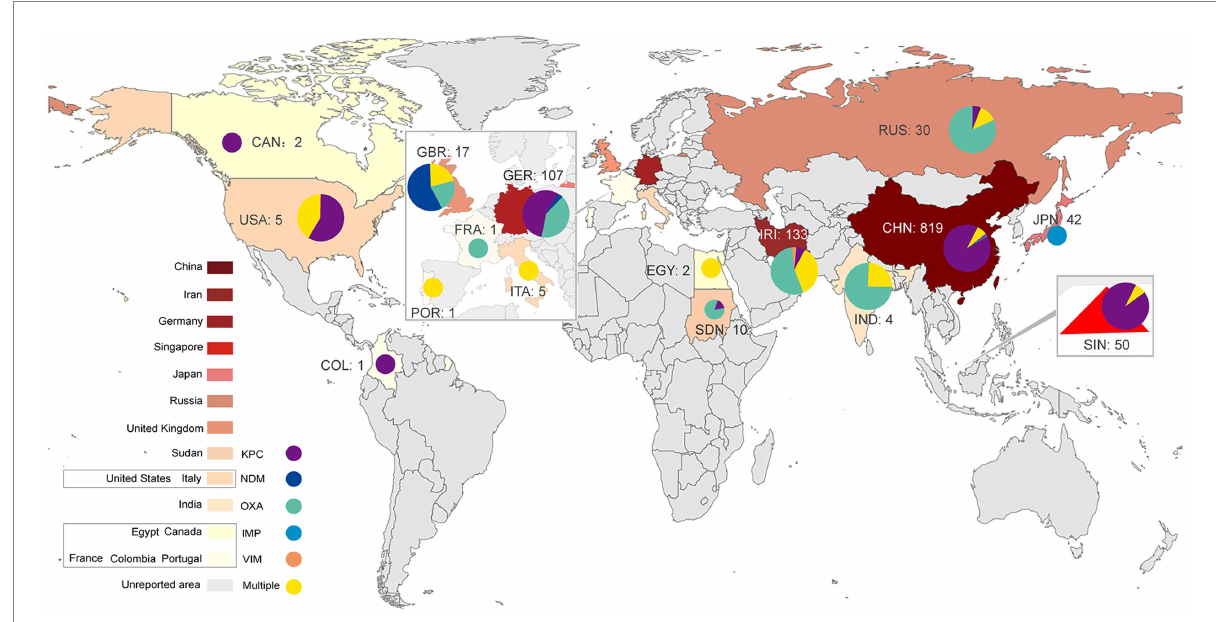
FIGURE 1 Global distribution of CR-hvKP (2015–2022). KPC, Klebsiella pneumoniae carbapenemase; NDM, New Delhi metallo- β -lactamase; VIM, Verona integron-encoded metallo- β -lactamase; IMP, imipenemase; OXA,